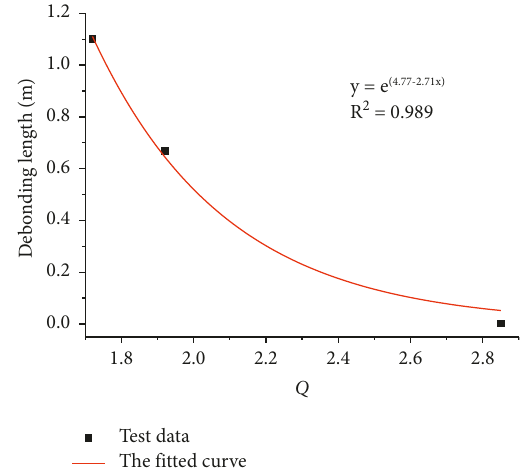
Figure 4: The relationship of Q value and debonding